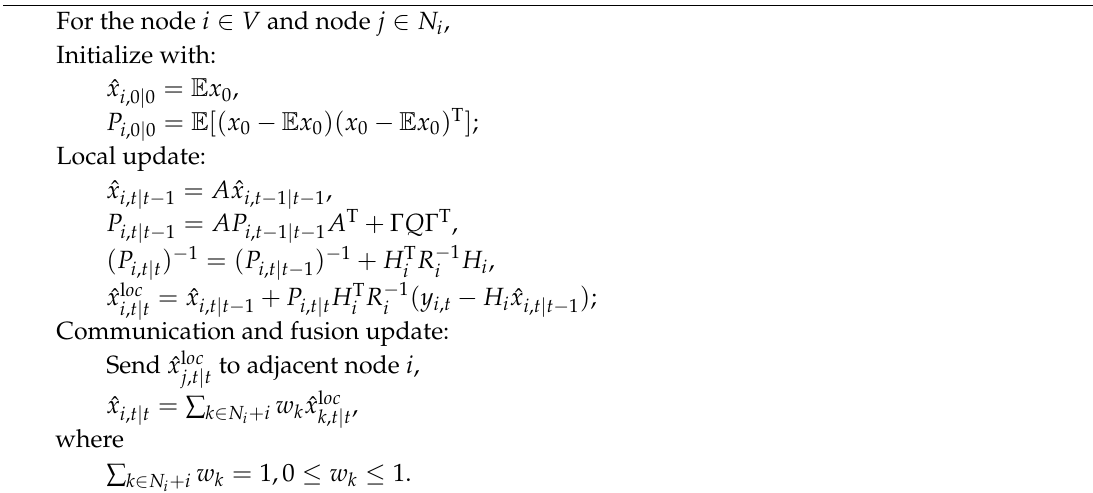
Algorithm 1: The seminal diffusion distributed Kalman